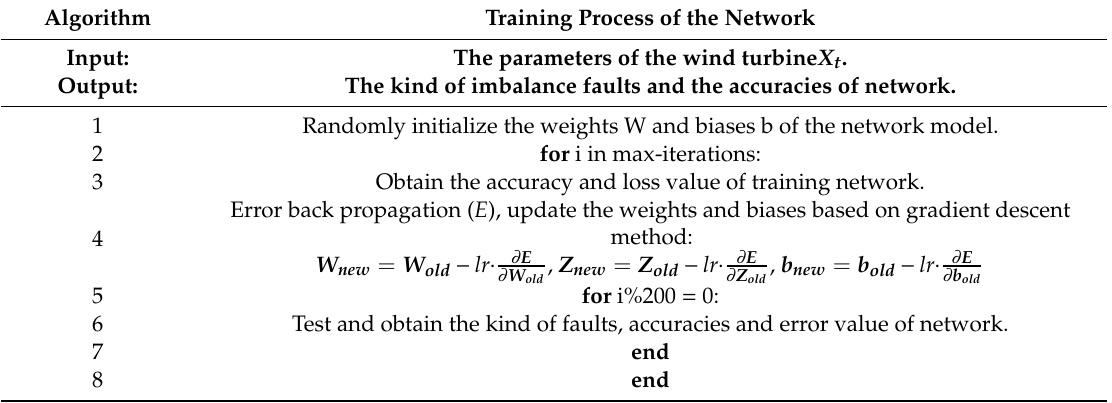
Table 1. The training process of the algorithm of the neural